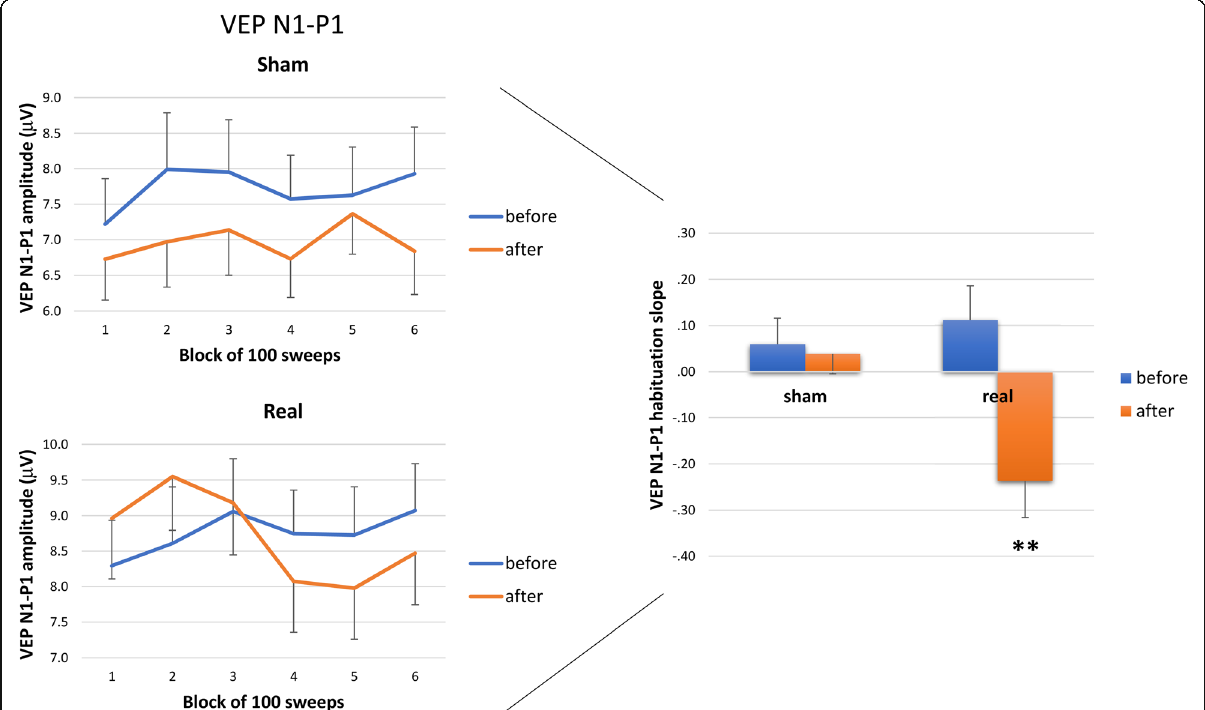
Fig. 1 Left panel: Amplitudes (mean ± standard error of the mean) of the N1 – P1 visual evoked potential (VEP) component in 6 sequential blocks of 100 recordings are shown before and after sham tDCS (upper panel) and anodal tDCS (lower panel). Right panel: The bar graph represents the habituation slope of VEP N1 – P1 peak-to-peak amplitudes (mean ± standard error of the mean) before and after sham tDCS and real tDCS. The arrow highlights interictal VEP habituation that was reduced before real tDCS but normalized after. ** = p < 0.01 before vs. after the